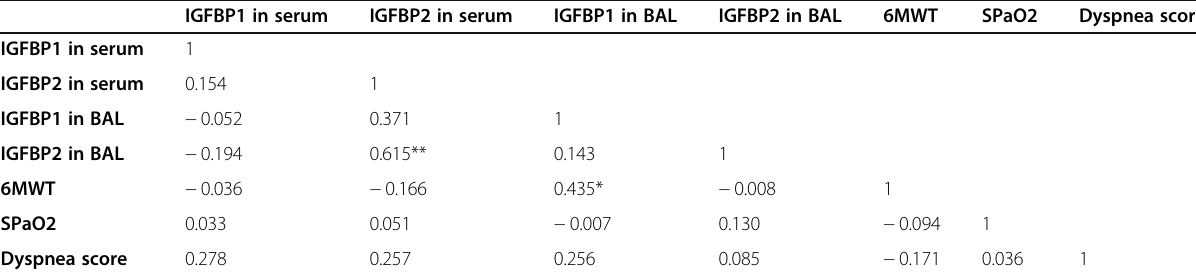
Table 4 Correlation between some biomarkers and dyspnea score in UIP group before treatment IGFBP1 in serum IGFBP2 in serum IGFBP1 in BAL IGFBP2 in